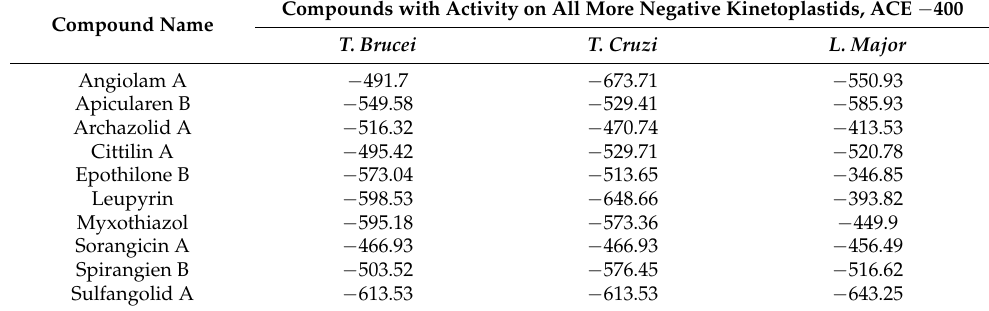
Table 3. Myxobacteria Compounds with activity on all more negative kinetoplastids, ACE −